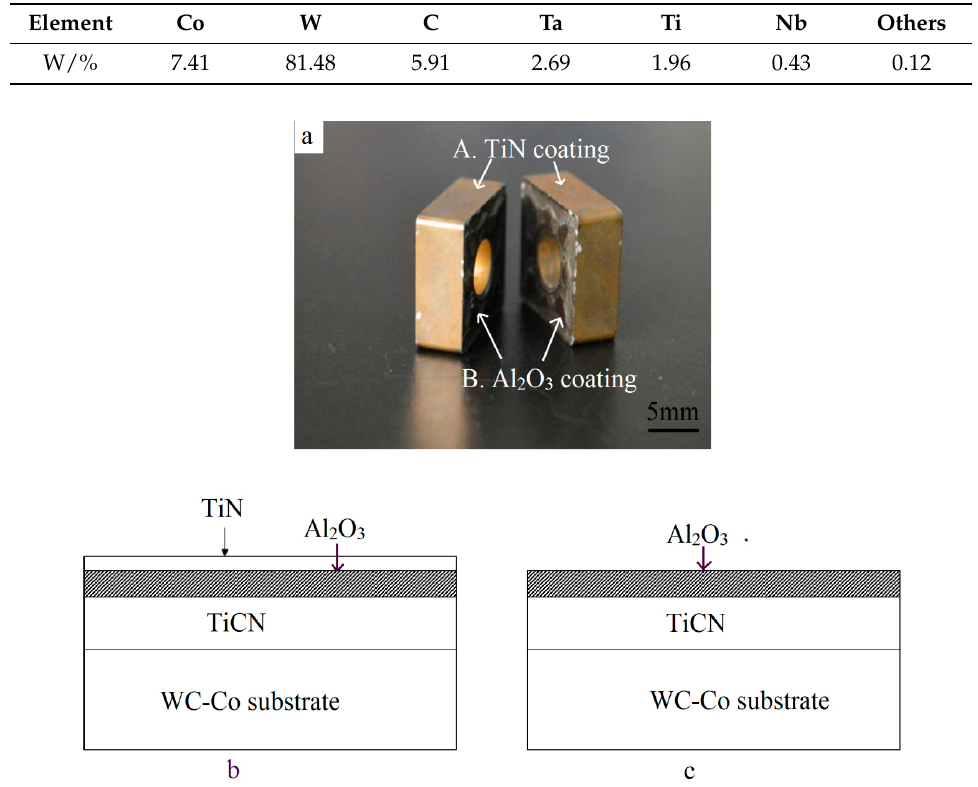
Figure 1. Multilayer coating on the multicomponent substrate. ( a ) Macrograph; ( b ) schematic of the TiCN/Al 2 O 3 /TiN coating on four flanks; and ( c ) schematic of the TiCN/Al 2 O 3 coating on the two front surfaces.